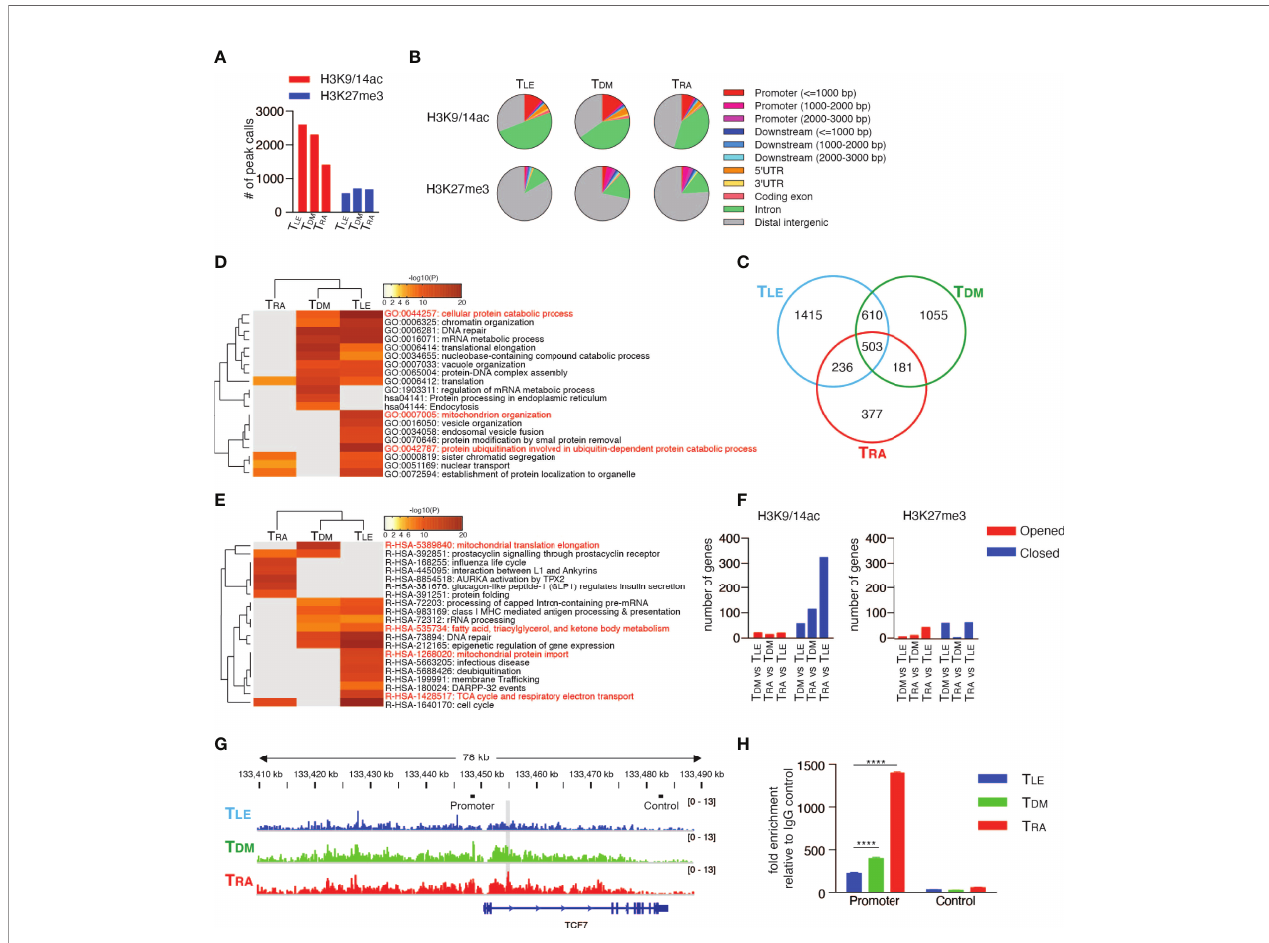
FIGURE 7 | RAR signaling deletes memory T cell pro fi le through comprehensive histone modi fi cations. ChIP-seq using the Illumina HiSeq2500 system was performed with T DM , T RA , and T LE cells for both H3K9/14ac and H3K27me3. (A) The number of peak calls. (B) Pie charts show the proportion of H3K9/14ac- and H3K27me3-occupied genomic regions. (C) Venn diagram shows the number of genes located within ±10 kb of H3K9/14ac-occupied regions. Genes were fi ltered as follows: p < 1e-5, Fold Enrichment ≥ 5, and Peak Tag count ≥ 5. (D, E) Metascape analysis was performed on the uniquely H3K9/14ac-occupied genes (i.e., 1415 genes in T LE , 1055 genes in T DM , and 377 genes in T RA , as described in (C) . Pathway and Process Enrichment analyses were performed using default settings without Reactome Gene Sets (D) and using only Reactome Gene Sets (E) . (F) Genes located within ±10 kb of H3K9/14ac- and H3K27me3-occupied regions were extracted for the indicated comparison and categorized as closed and opened genes, respectively, during differentiation. The number of closed and opened genes is shown. (G) The patterns of H3K27me3 peaks at the TCF7 locus are shown. The gray shadow indicates the region that was detected as a peak call in the comparison between T LE and T RA cells. Bars indicated as Promoter or Control are positions of amplicons for ChIP-qPCR (H) . (H) A ChIP assay was performed for H3K27me3-occupied genes in the naïve CD8+ T cells treated with DMSO, RA, or LE540. Representative data are shown from two independent experiments. Data were analyzed by one-way ANOVA with post-hoc tests. Error bars show SD. ****p <